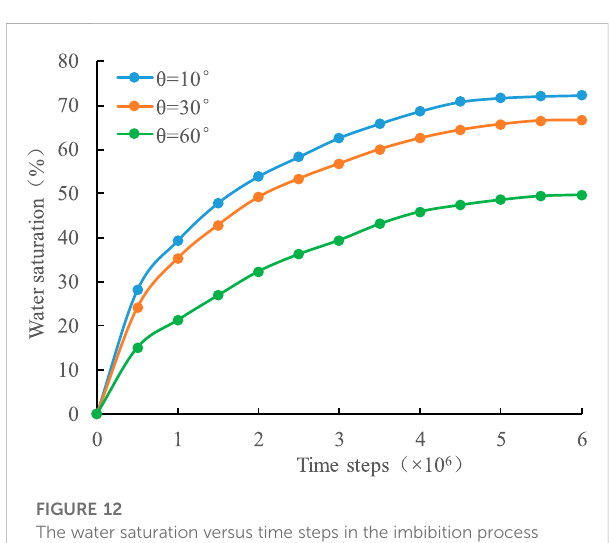
FIGURE 12 The water saturation versus time steps in the imbibition process under different contact